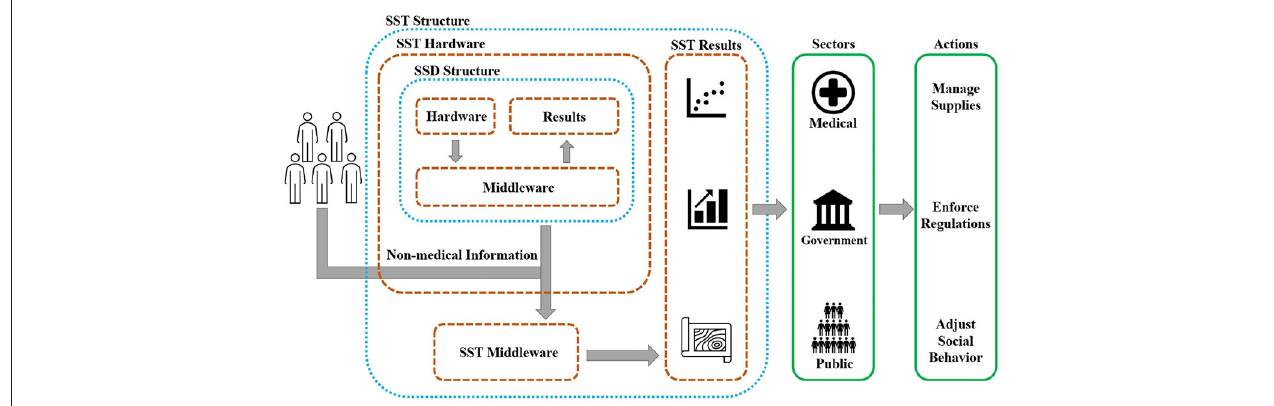
FIGURE 2 | Functionality of